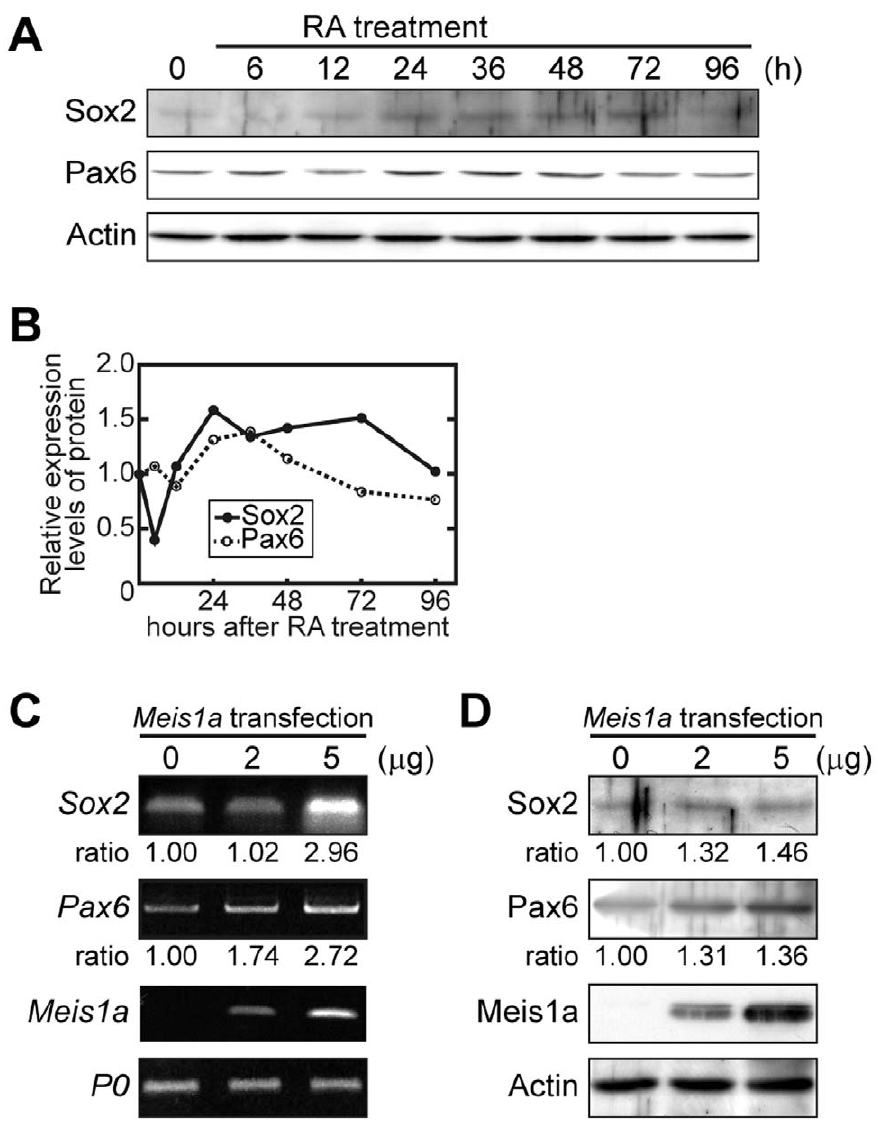
Figure 6. Effect of Meis1a on Sox2 and Pax6 expressions. ( A ) Expression patterns of Sox2 and Pax6 during neural differentiation. Aggregated P19 cells were treated with RA for various times and analyzed by WB with anti-Sox2 and Meis1 antibodies. ( B ) Quantification of expression levels of Sox2 and Pax6 as shown in A . ( C and D ) Stimulation of Sox2 and Pax6 mRNA and protein expressions by ectopic expression of Meis1a. Monolayer- cultured P19 cells were transfected with various amounts of pcDNA3-EF1- a - Meis1a and after 12 h, Sox2 and Pax6 mRNAs and proteins were analyzed by RT-PCR ( C ) and WB ( D ), respectively.